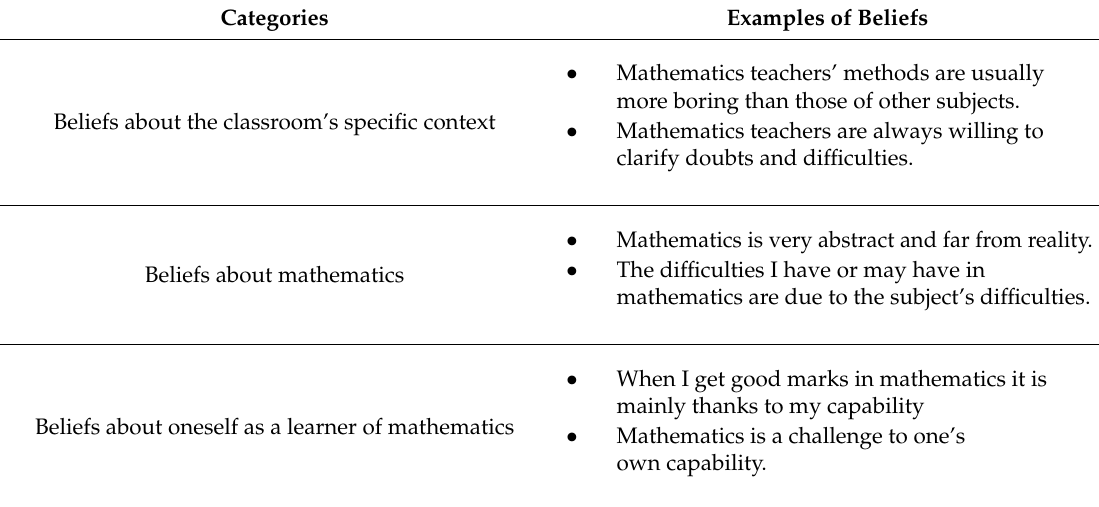
Table 1. Description of the categories of beliefs.